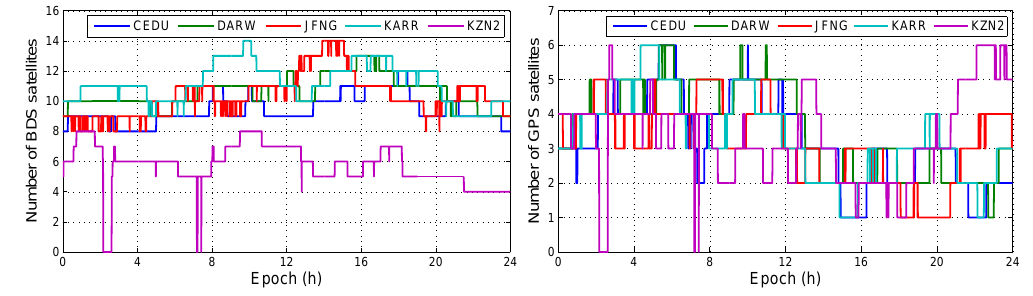
Figure 3. The number of BDS/GPS satellite with triple-frequency observation data.